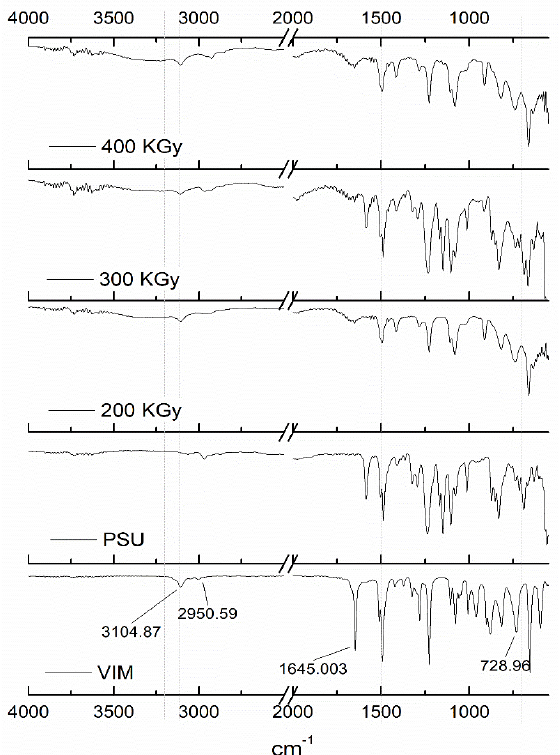
Figure 2. FTIR spectra of grafted PSU membranes with VIM 50% (v/v) and gamma radiation at different irradiation absorption doses: 200, 300 and 400 kGy.